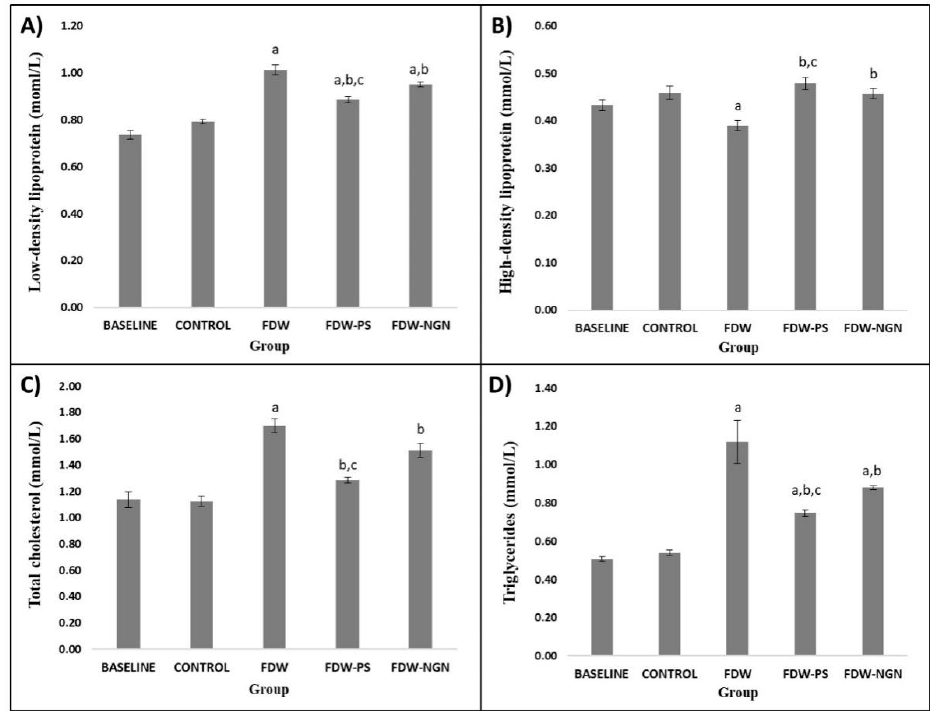
Figure 6. Lipid profiles comprising of low density lipoprotein ( A ), high density lipoprotein ( B ), total cholesterol ( C ), and triglycerides ( D ) of all groups over 12 weeks. Values are mean ± SD and n = 8 for each group. Superscript letters indicate significantly different. a p < 0.05 compared to the control group. b p < 0.05 compared to the FDW group. c p < 0.05 compared to the FDW-NGN group. FDW: Olive oil + 20% fructose; FDW-PS: PS + 20% fructose; FDW-NGN: Naringin + 20% fructose.